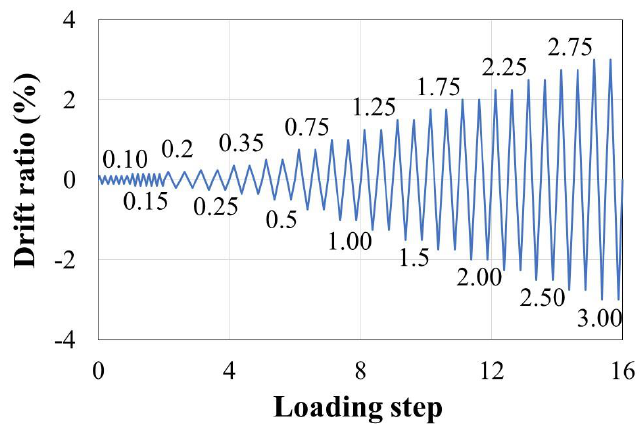
Figure 3. Drift history for cyclic loading test.